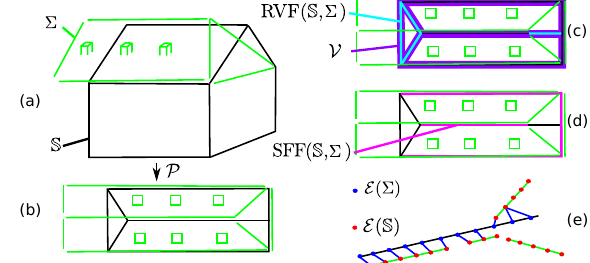
Figure 4: Illustration of the proposed functions for DB error